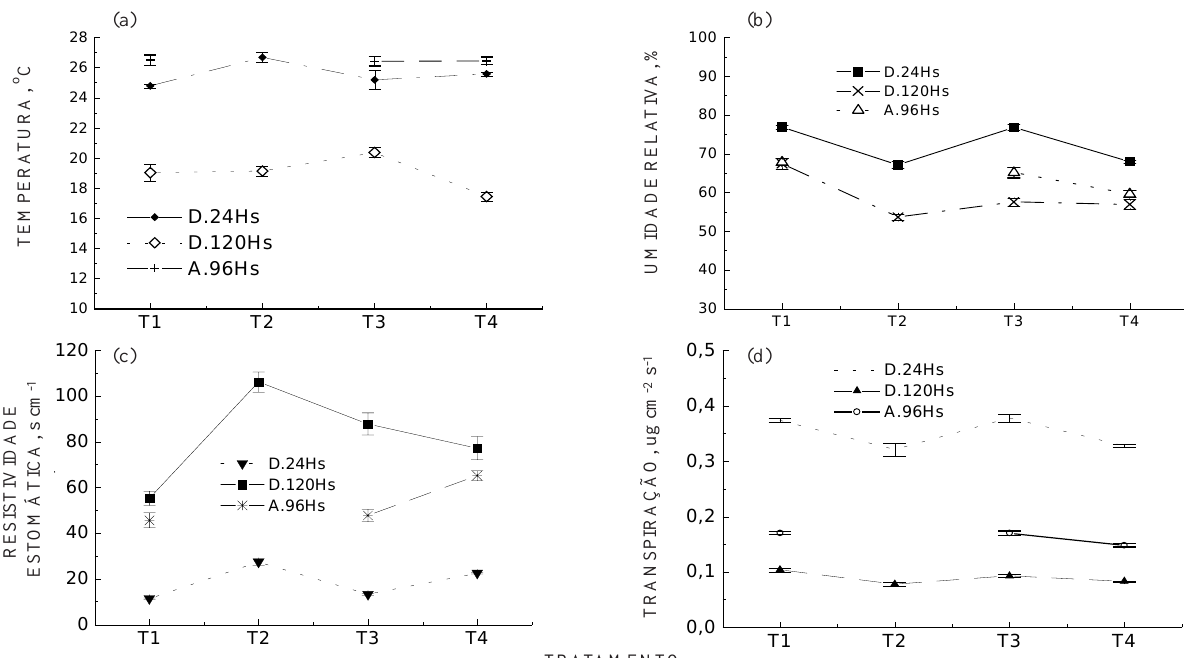
Figura 7. Alterações nos processos de transferência hídrica da planta com a atmosfera (a) Temperatura da folha; b) Umidade relativa; (c) Resistência estomática e (d) Taxa transpirométrica, nos diferentes tratamentos, as 24 h (D.24Hs), 120 h (D.120Hs) do início do TAH e 96 h (A.96Hs) após o término do